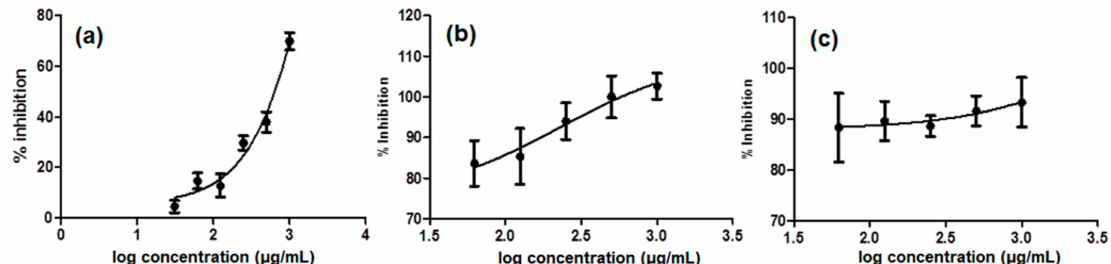
Figure 2. The drug dose-dependent curves of ( a ) Ageratum conyzoides (AC) n -hexane (IC 50 246.1 µ g/mL; R 2 0.9620), ( b ) Ixora coccinea (IC) n -hexane (IC 50 5.66 µ g/mL; R 2 0.5036), and ( c ) IC ethylacetate (IC 50 2.75 × 10 − 2 µ g/mL; R 2 0.0754) as the results of Fluorescence Resonance Energy Transfer (FRET)-based assay toward MMP9. N -isobutyl- N -(4-methoxyphenylsulfonyl)- glycyl hydroxamic acid (NNGH) was used as the positive control (IC 50 47.8 nM). The bars show the standard error of the triplicate assay as previously